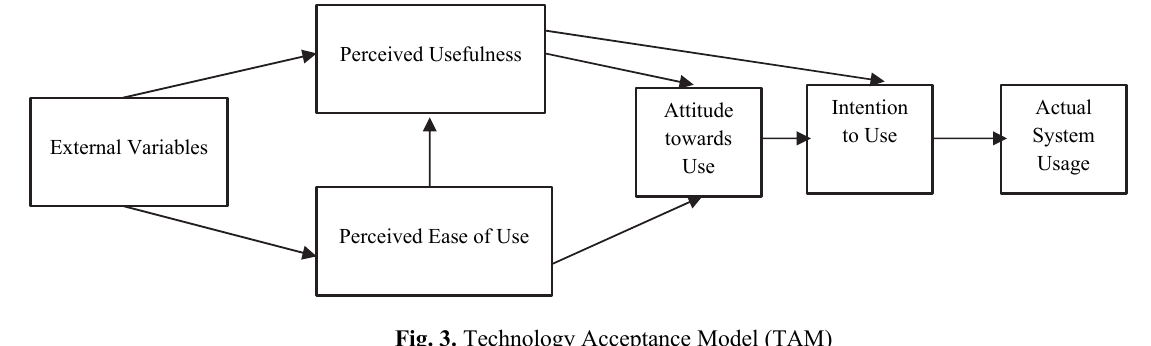
Fig. 3. Technology Acceptance Model